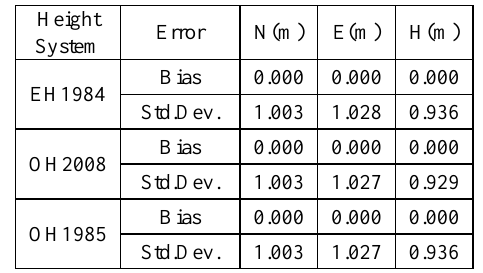
Table 5. The bias and the standard deviation of all GCPs with the different height systems